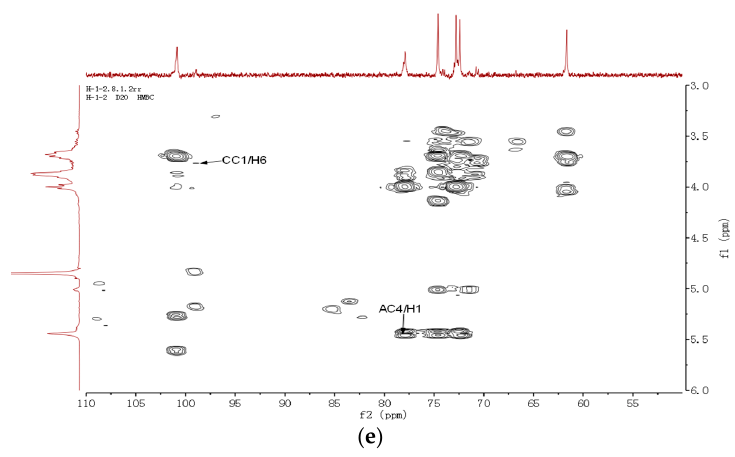
Figure 3. The NMR spectroscopy of H-1-2: ( a ) 1 H-NMR spectroscopy of H-1-2; ( b ) 13 C-NMR spectroscopy of H-1-2; ( c ) H-HCOSY spectroscopy of H-1-2; ( d ) HSQC spectroscopy of H-1-2; and ( e ) HMBC spectroscopy of H-1-2. Table 2. 1 H-NMR and 13 C-NMR chemical shift correlation values of H-1-2.